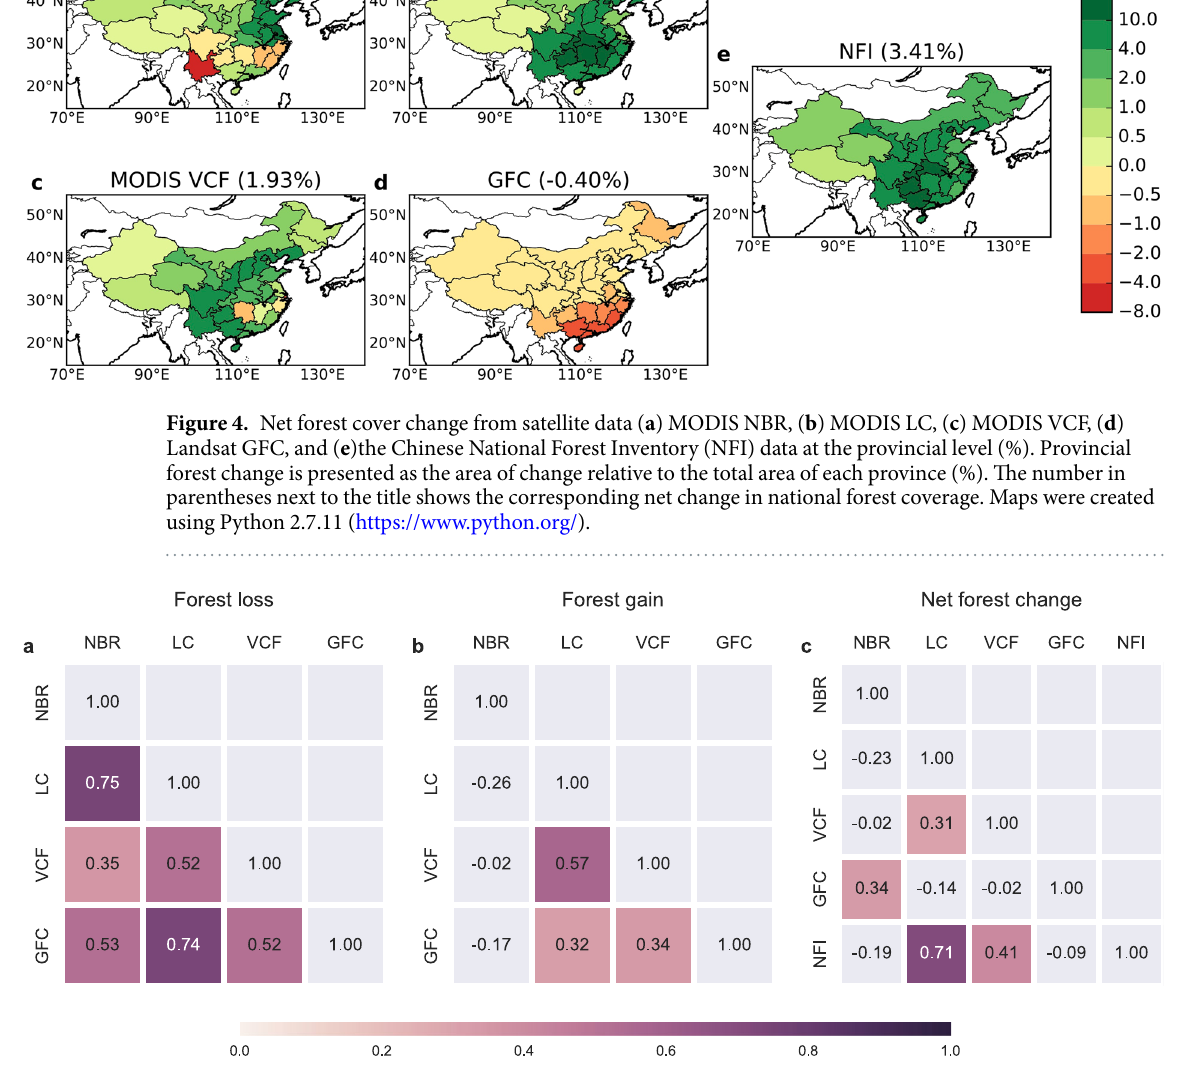
Figure 5. Correlations at provincial level of ( a ) forest loss, ( b ) forest gain, and ( c ) net forest change between the four satellite datasets and the statistical NFI data. Provincial forest change area was divided by the land area of each province to convert to forest coverage prior to the correlation calculation. Each box in the correlation matrix contains a value of Pearson correlation between two given datasets. The NFI data were only available for estimates of the net forest change. Insignificant correlations by t -test at 90% level are presented in grey color. A similar figure but for the weighted correlations (forest cover change area weighted by the amount of provincial forest area) is provided in Supplementary Fig. S3. The provincial statistics for forest loss, gain, and net change are provided in Supplementary Tables S2 to